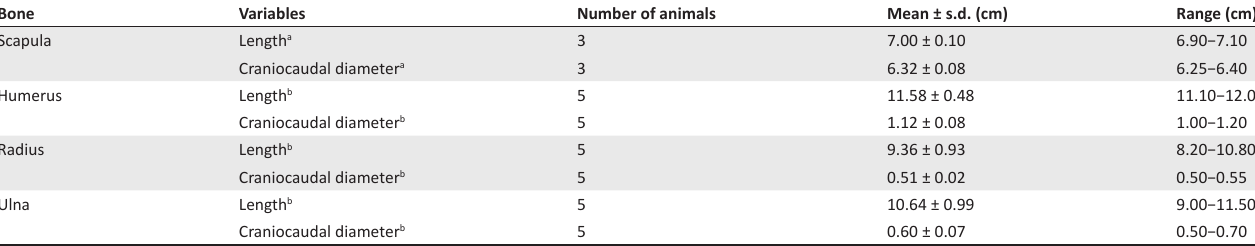
TABLE 1: Measurements of the scapula, humerus, radius and ulna in captive red pandas. Bone